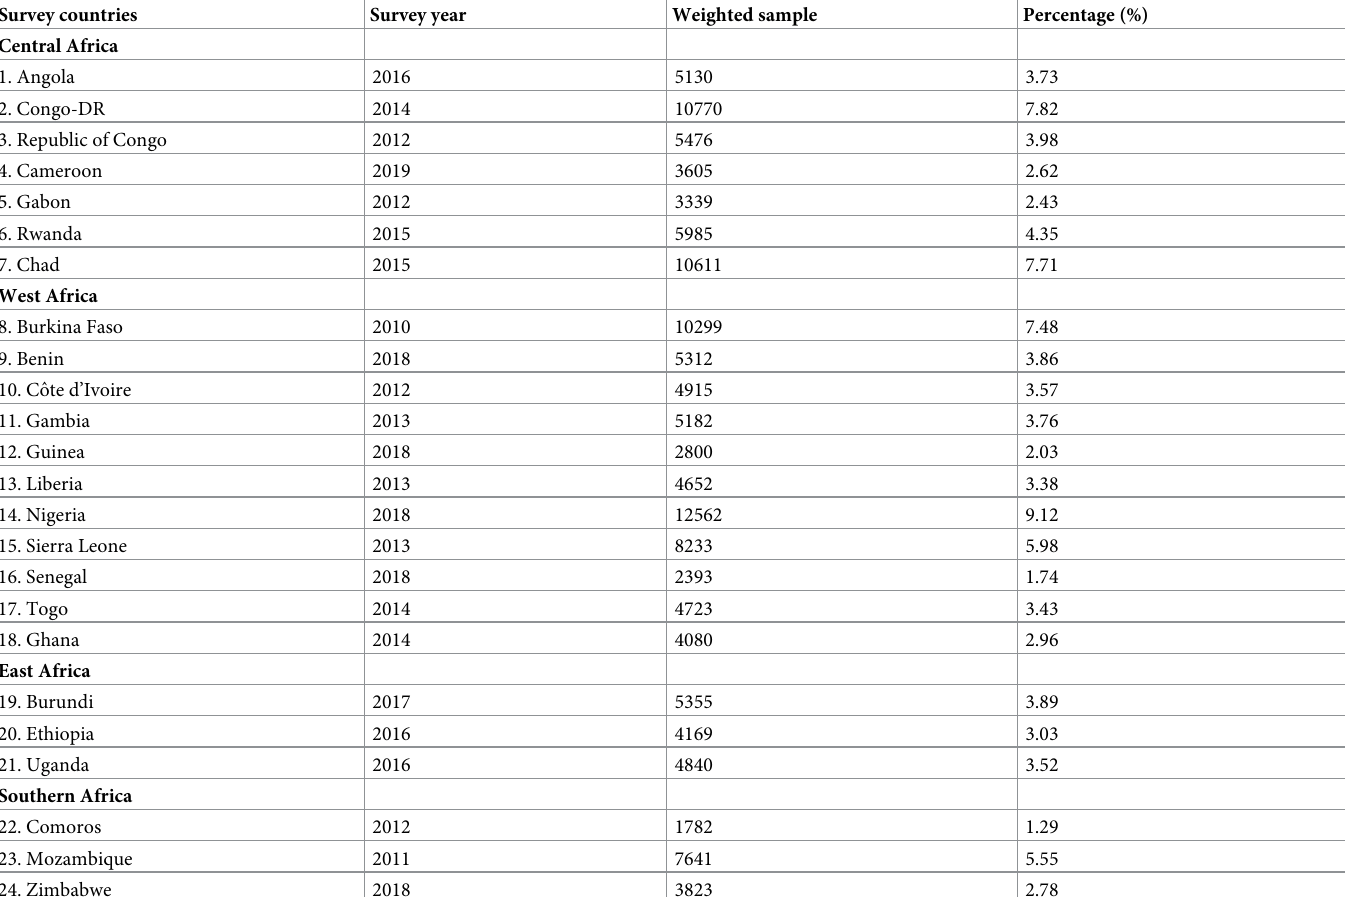
Table 1. Sample size distribution by country and survey